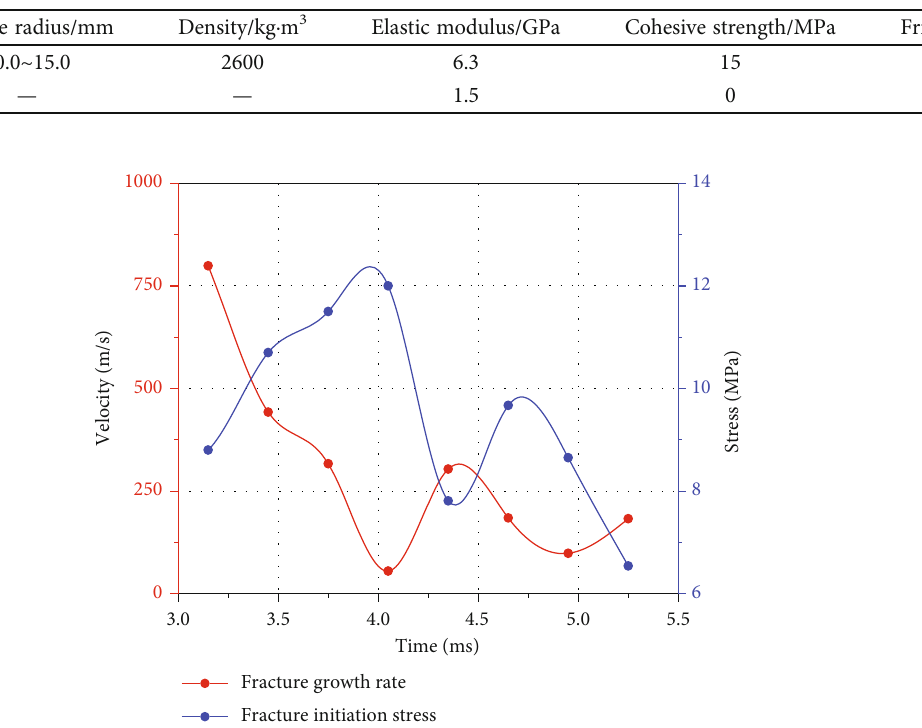
Figure 5: Curves of fracture growth rate and horizontal peak stress at the crack initiation point vs. time.